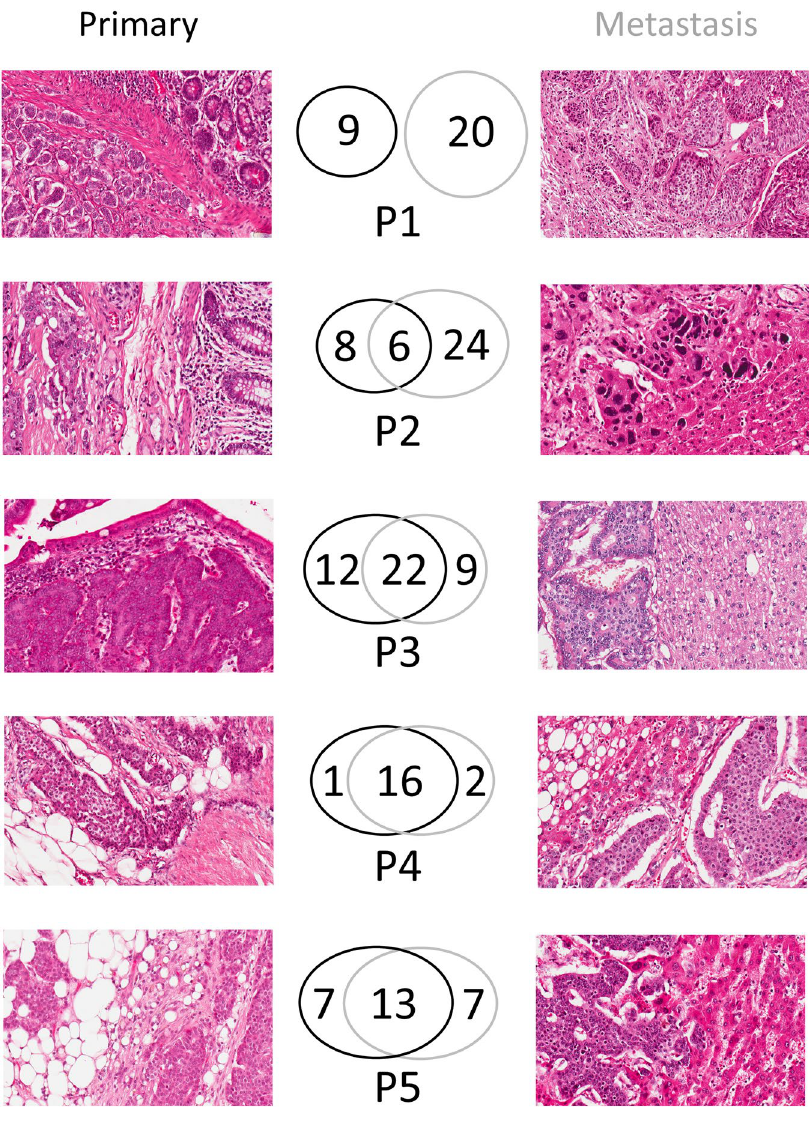
Figure 2. Mutational heterogeneity and representative hematoxylin and eosin stained sections of primary and metastasis. Representative areas of hematoxylin and eosin-stained slides of primary lesion (left) and metastasis (right) of small intestine neuroendocrine tumors (SI-NET) of Patient 1–5 (P1–P5). Mutations only present in the primary tumor are surrounded of black circles while mutations only present in metastasis are within grey circles. Common mutations (present in primary and metastatic SI-NET) are within the intersection. If available, areas with infiltration into benign surrounding tissue (e.g. ileal mucosa, liver tissue) were chosen. In the metastasis sample of Patient 2, only an instantaneous section was available. Magnification: